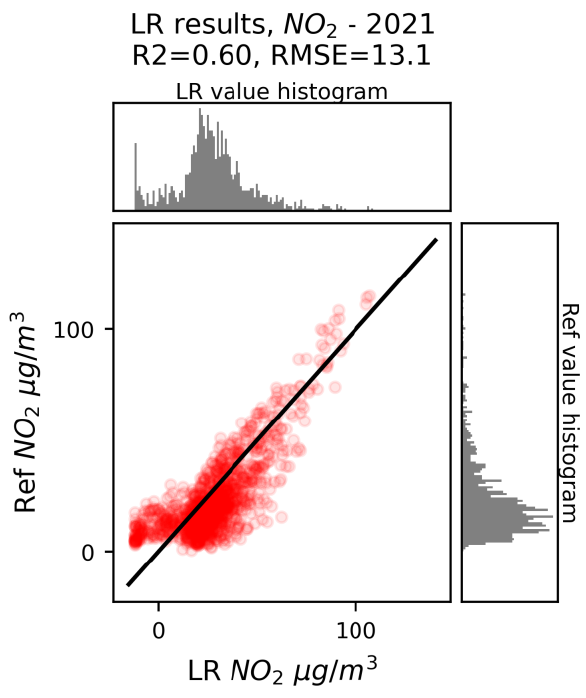
Figure 4. The results of the LR performed in the year 2021.